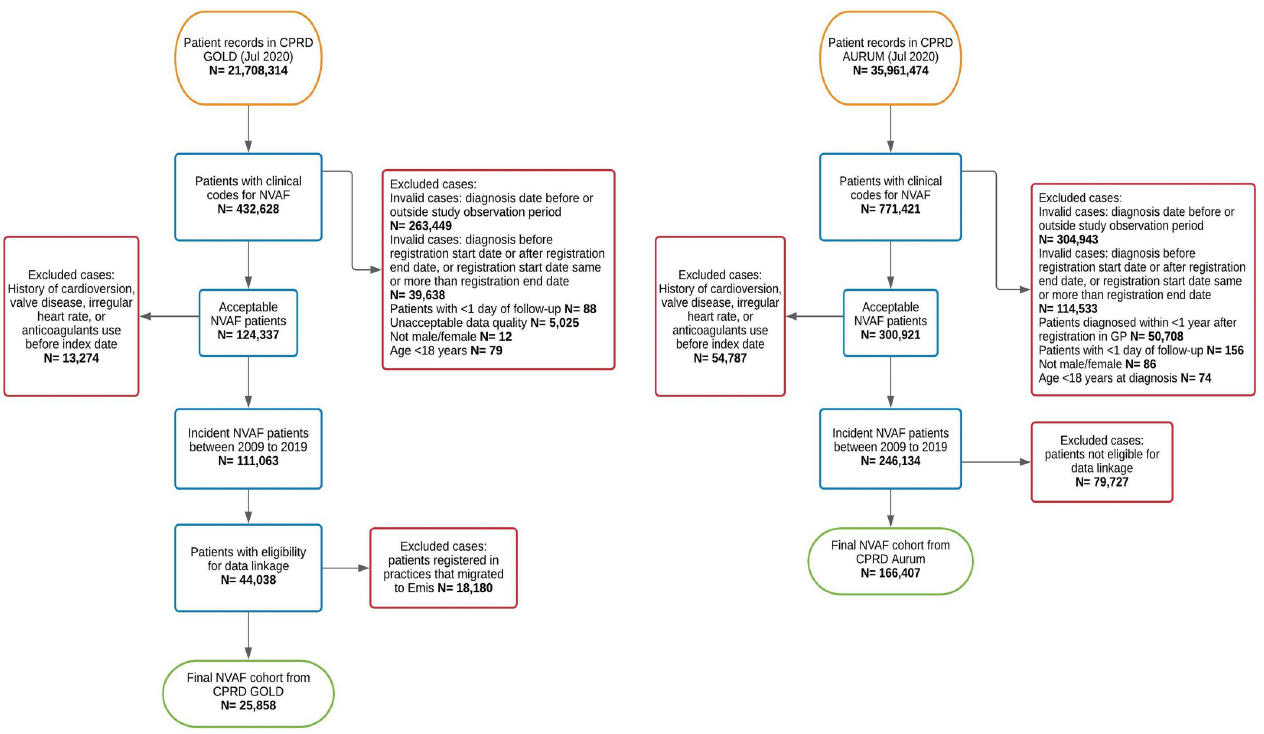
Fig 2. A flow chart of the study inclusion/exclusion criteria in CPRD GOLD and Aurum. CPRD, Clinical Practice Research Datalink; GP, general practice; NVAF, nonvalvular atrial fibrillation.